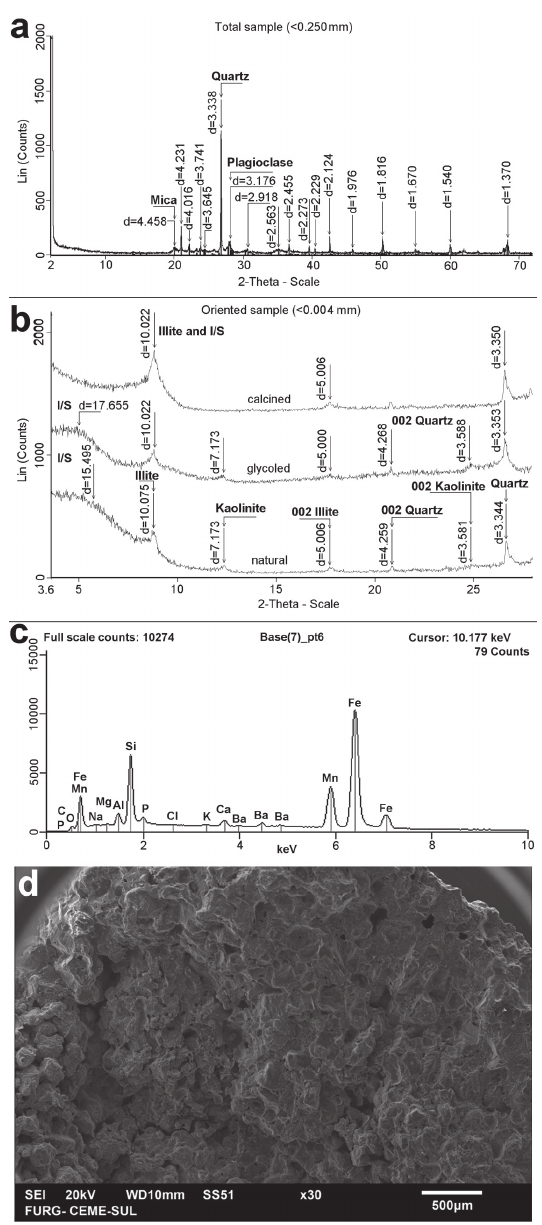
Figure 6 - Diffractograms showing the mineral composition of the total ( a ) and clay ( b ) fractions of the loess. ( c ) is the mineral composition and ( d ) is a MEV image of an iron- manganese nodule from the